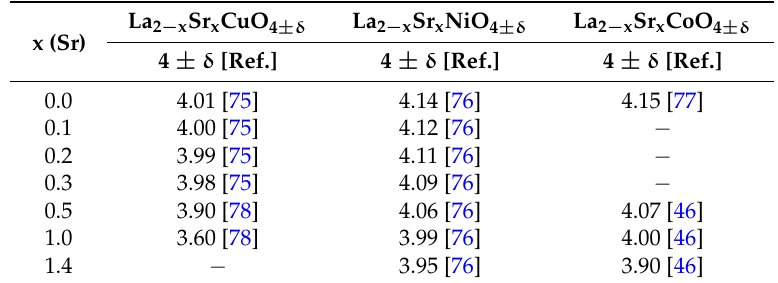
Table 2. Oxygen stoichiometry in La 2 − x Sr x MO 4 ± δ (M = Cu, Ni, and Co) with various Sr contents. Oxygen nonstoichiometry of each of the samples was ascertained under reduction in air between 850 and 950 ◦